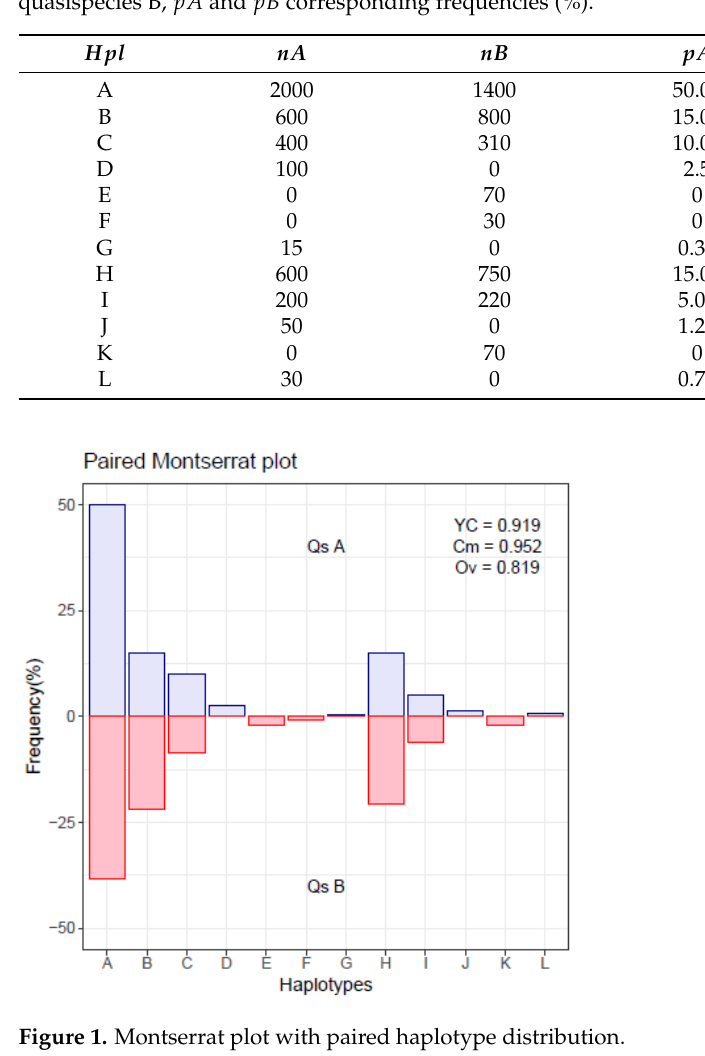
Figure 1. Montserrat plot with paired haplotype